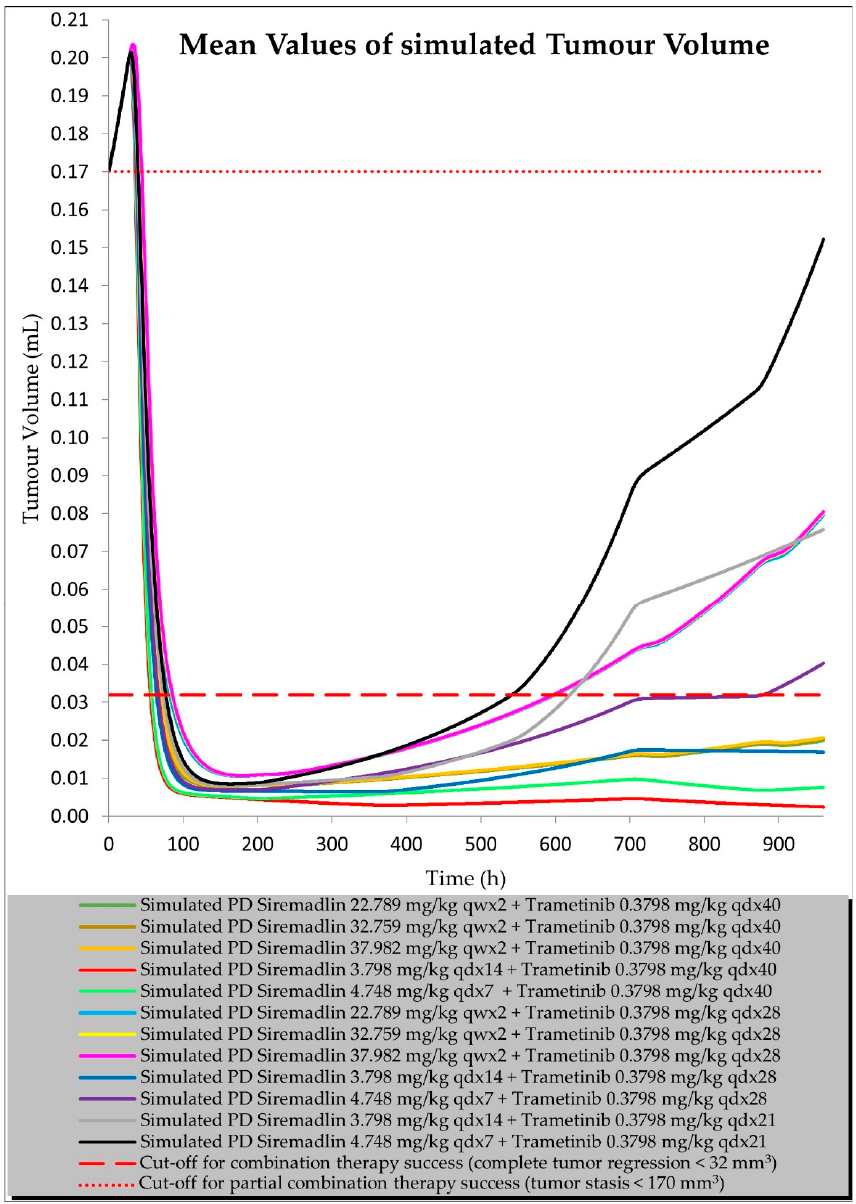
Figure 10. Simulation of siremadlin and trametinib combination efficacy at HEDs (2 therapy cycles) using universal TGI